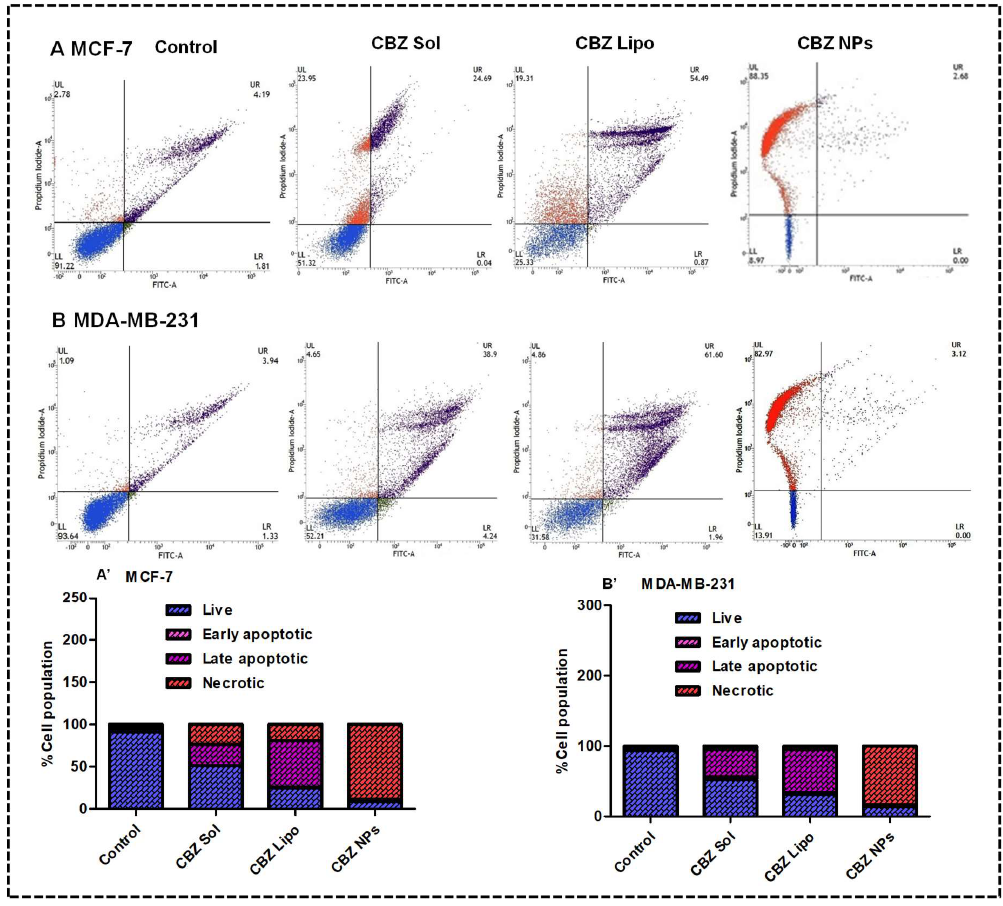
Figure 7. Cytometric detection of apoptosis on the MCF-7 and MDA-MB-231 cell lines: the Lower Left (LL) quadrant represents live cells, the Lower Right (LR) quadrant represents cells that are in the early apoptotic phase, the Upper Right (UR) quadrant represents cells that are in the late apoptotic phase, and the Upper Left (UL) quadrant represents cells that are in the necrotic phase (Dead). ( A , B ) demonstrate the flow cytograms of the MCF-7 and MDA-MB-231 cell lines after treatment with the CBZ micellar solution, CBZ liposomes, and CBZ NPs along with their cells at different quadrants in comparison with control, respectively. ( A’ , B’ ) demonstrated the percentage of cell population in the live, early apoptotic, late apoptotic, and necrotic phases.